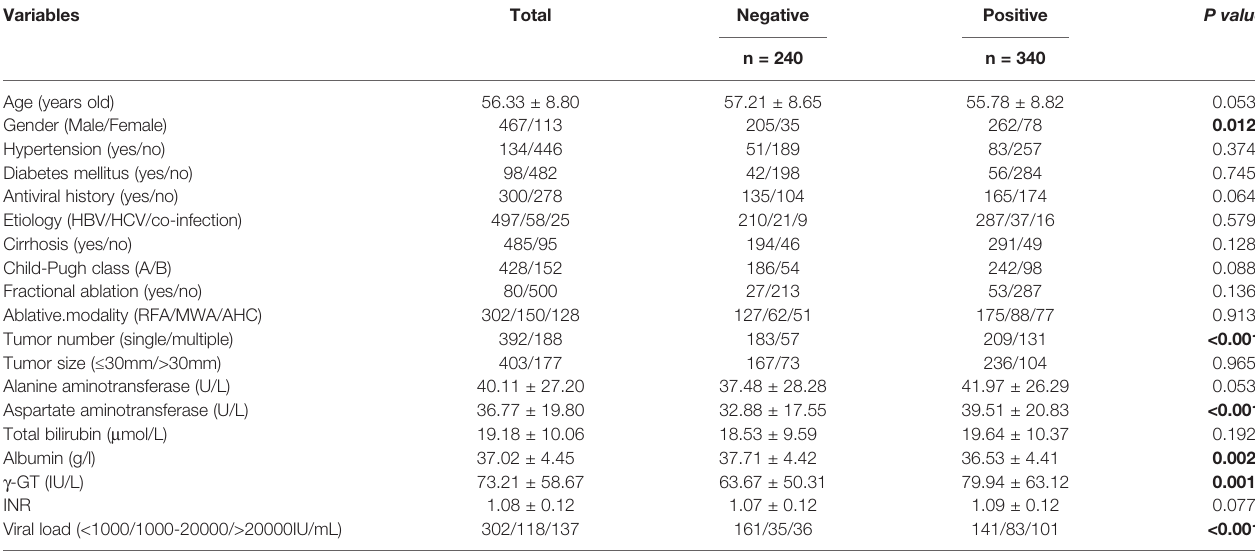
TABLE 1 | The association between APF at baseline and clinicopathological indicators.